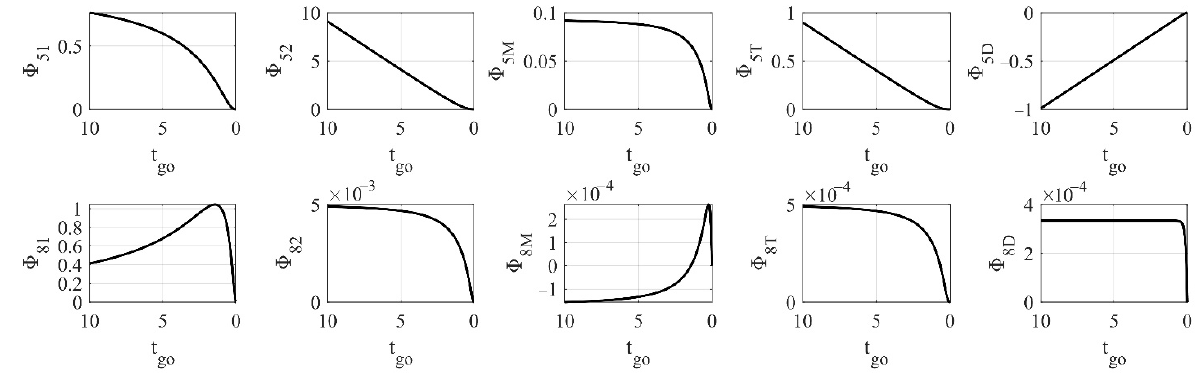
Figure 2. Transfer matrix elements for two-way cooperation.